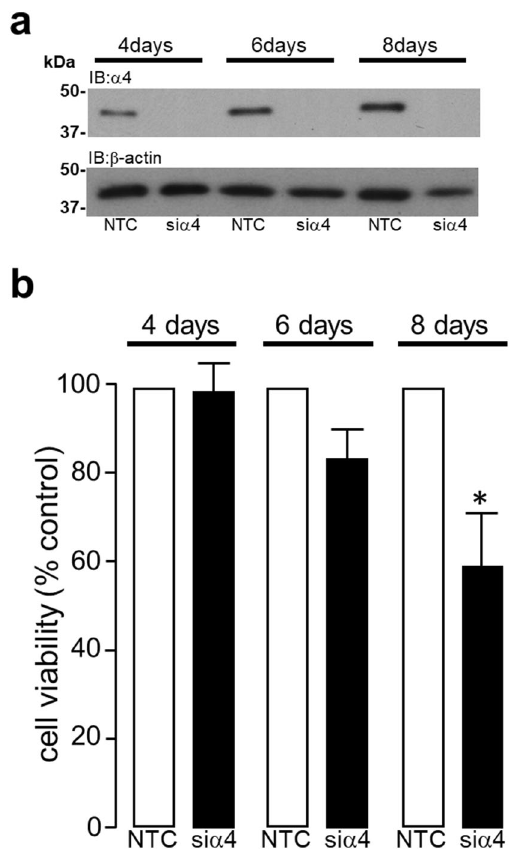
Figure 2. Long-term knockdown of α4 protein expression regulates DNA damage and cell death. H9c2 cardiomyocytes were transfected with either 50 nM non-targeting control (NTC) siRNA or 50 nM siRNA specific to rat α4 protein (siα4) for 4, 6 and 8 days and the KD of α4 protein (n = 4) was confirmed by Western analysis ( a ). The viability of H9c2 cardiomyocytes following the KD of α4 protein expression for 4, 6 and 8 days was determined by MTT assay, data represents mean values ± SEM of 3 individual experiments ( b ). All data represents mean values ± SEM and statistical significance was determined by ANOVA followed by a multiple comparison Tukey’s modified